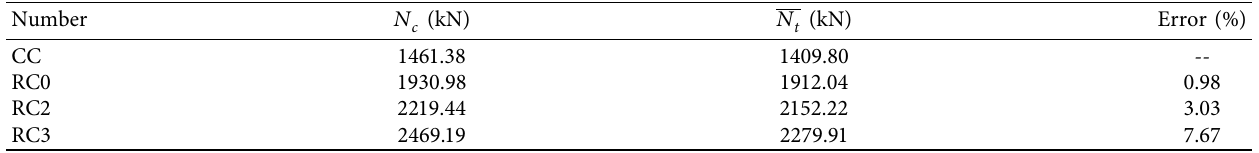
Table 3: Bearing capacity test results of each